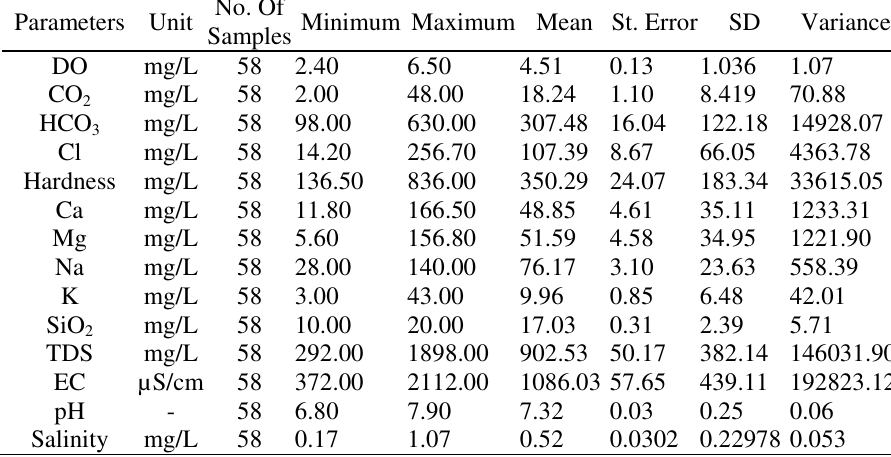
Table 2. Descriptive statistics of